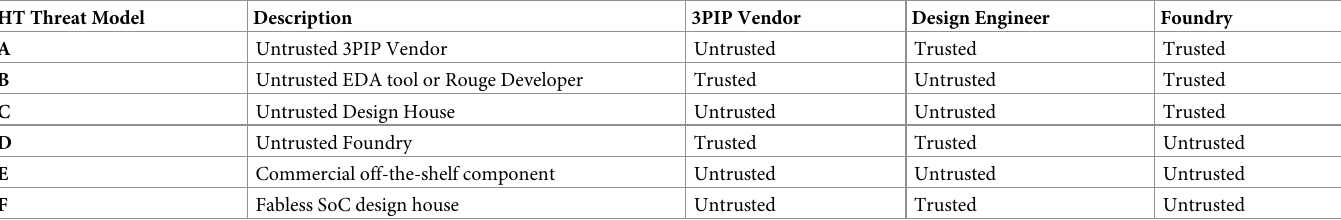
Table 1. Summarized threat model for AMS